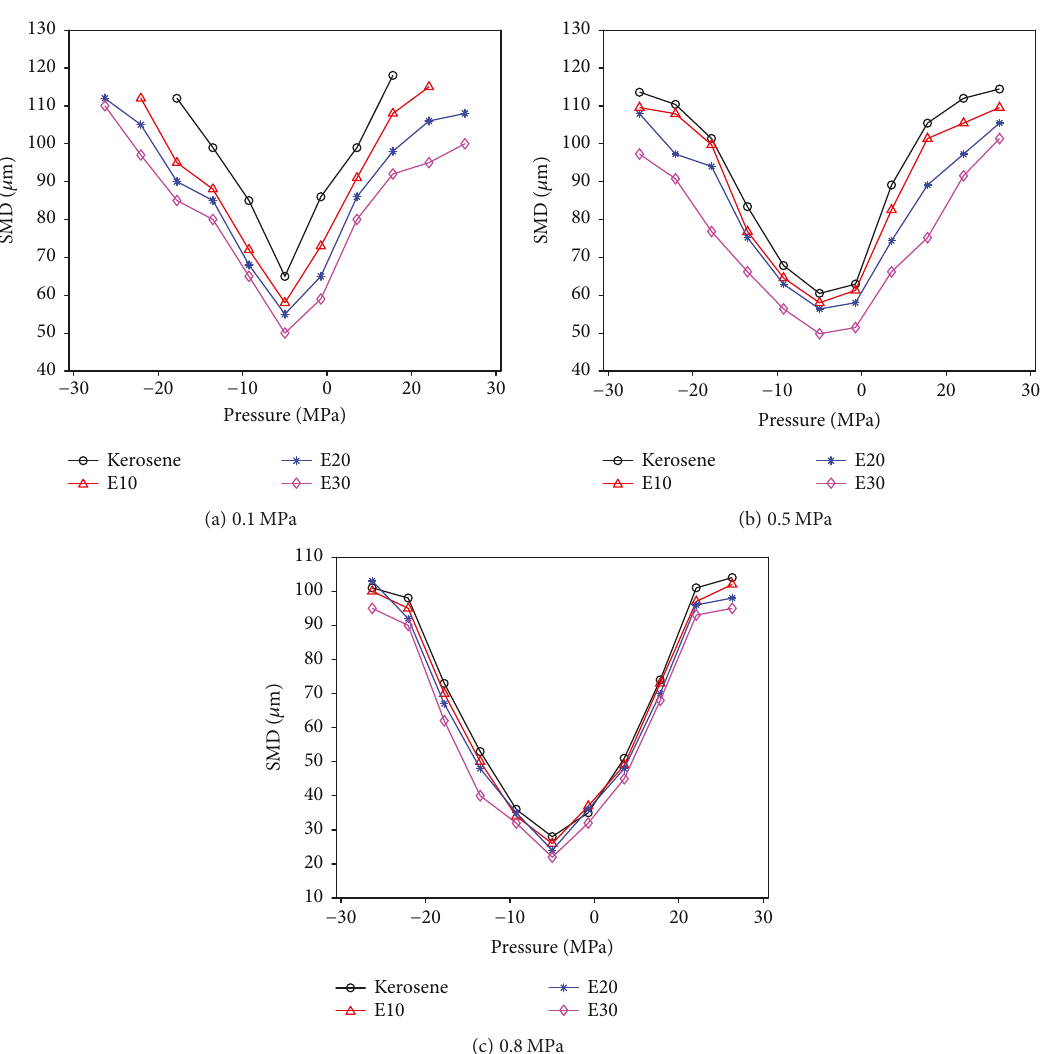
Figure 19: The SMD of blended fuels at y = − 25mm under 0.1, 0.5, and